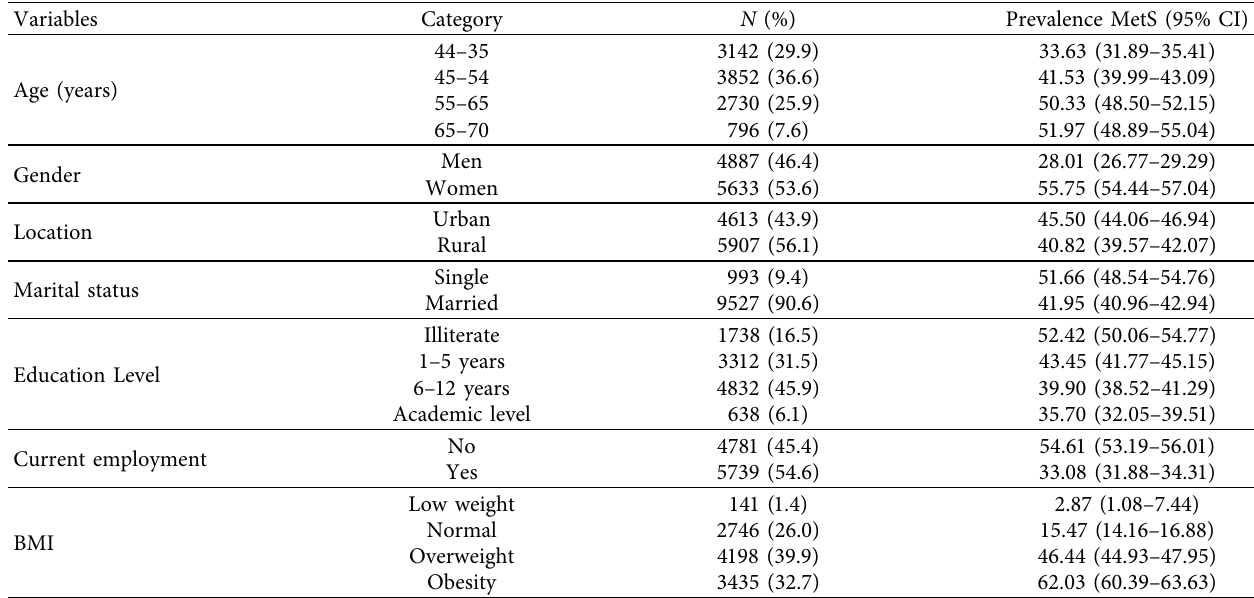
Table 1: Characteristics of demographic variables and prevalence of metabolic syndrome according on IDF definition ( n �